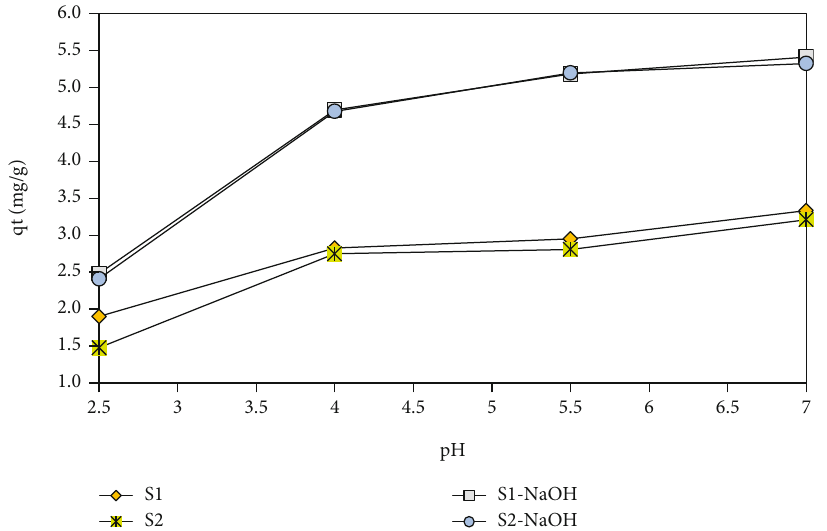
Figure 7: Cd adsorption capacity vs. pH using untreated and NaOH-treated samples of rice husk. (rice husk size S1: < 212 – 425 μ m > and S2: < 425 – 600 μ m > , 20 mg/L of Cd (II) using 150 mg of rice husk).